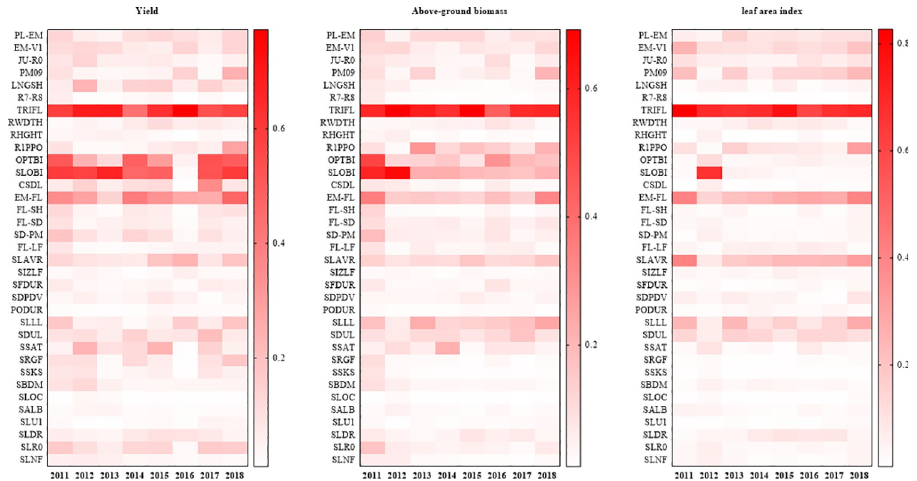
Fig 2. Temporal sensitivity indices for yield, aboveground biomass and LAI (2011–2018). Note . I: ecotype parameters; II: genotype parameters; III: soil parameters.